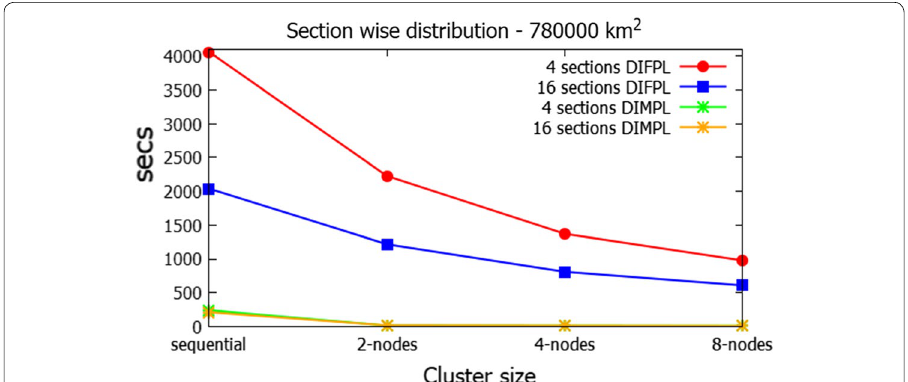
Fig. 18 Performance of section wide distribution in MapReduce and Spark for various sized clusters and a larger